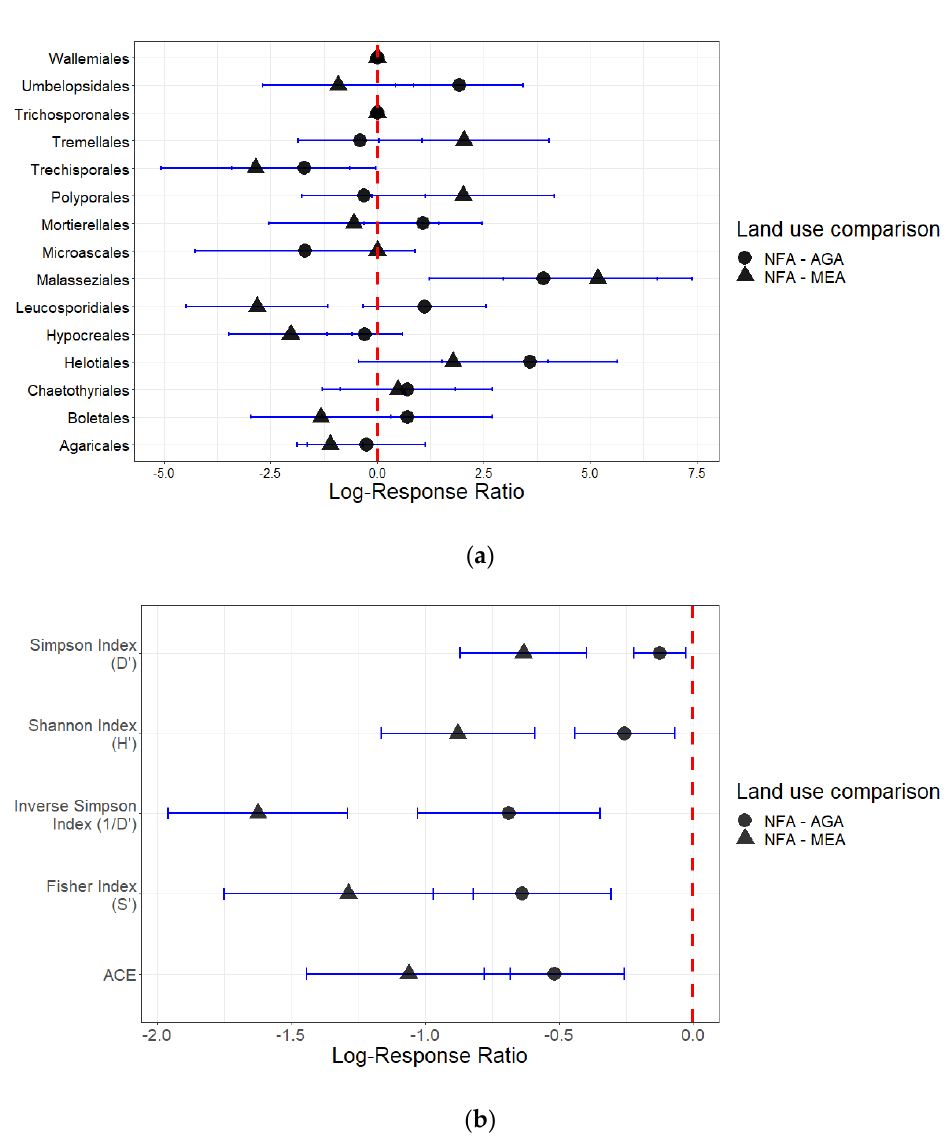
Figure 4. Log-response ratios (LogRR): ( a ) abundances of dominant order; ( b ) alpha diversity index values. (AGA = agricultural activities areas, MEA = mining extraction areas, NFA = natural forest areas). If the 95% CI of LogRR did not overlap with 0, then responses were significant at p < 0.05 level.